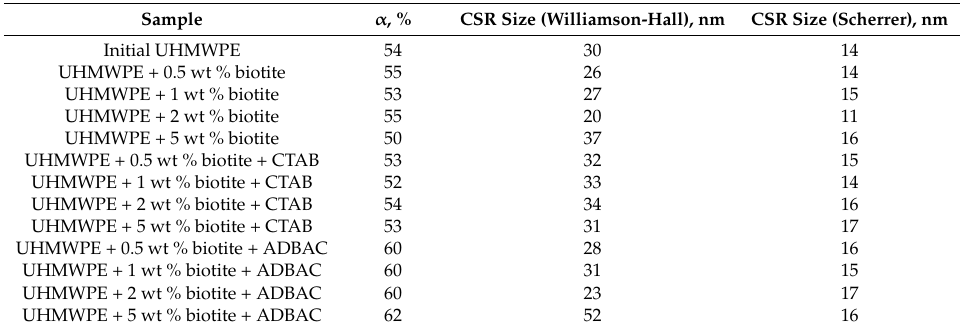
Table 1. X-ray diffraction data of polymer composites.